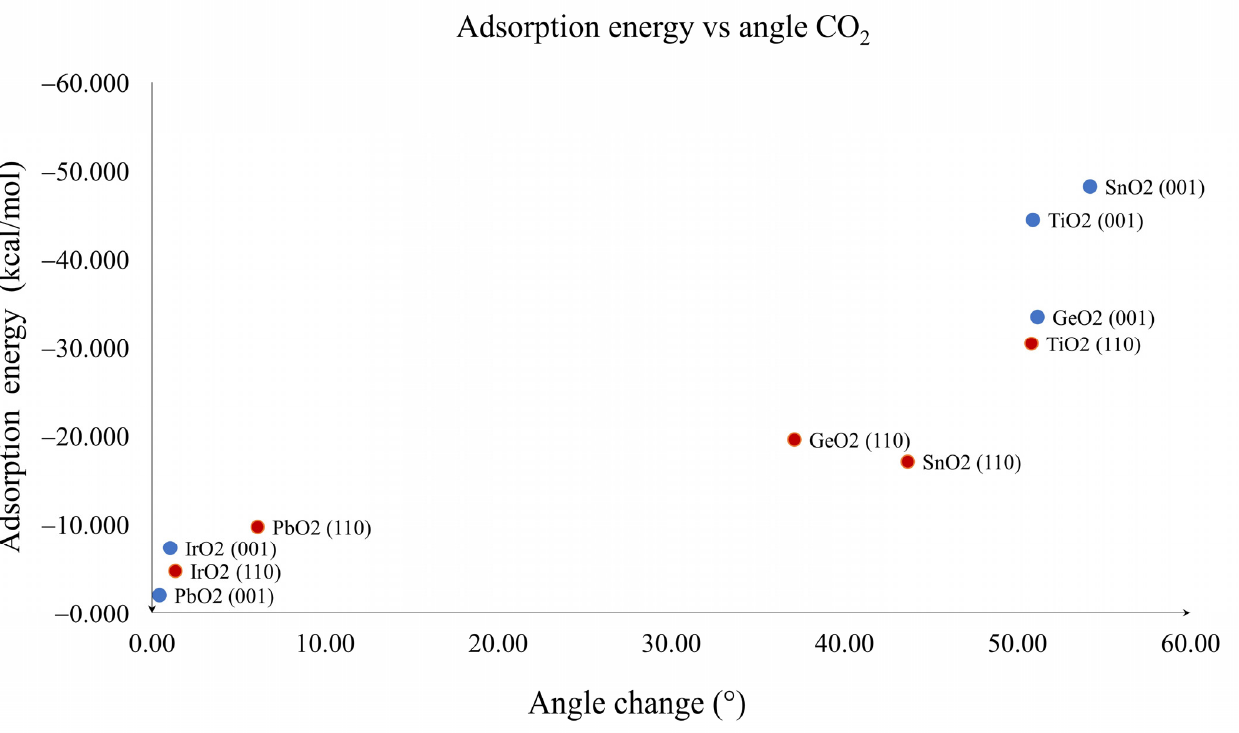
Figure 6. Relation between adsorption energy and CO 2 angle for TiO 2 , GeO 2 , SnO 2 , IrO 2 and PbO 2 . (001) planes are blue dots and (110) planes are red dots.